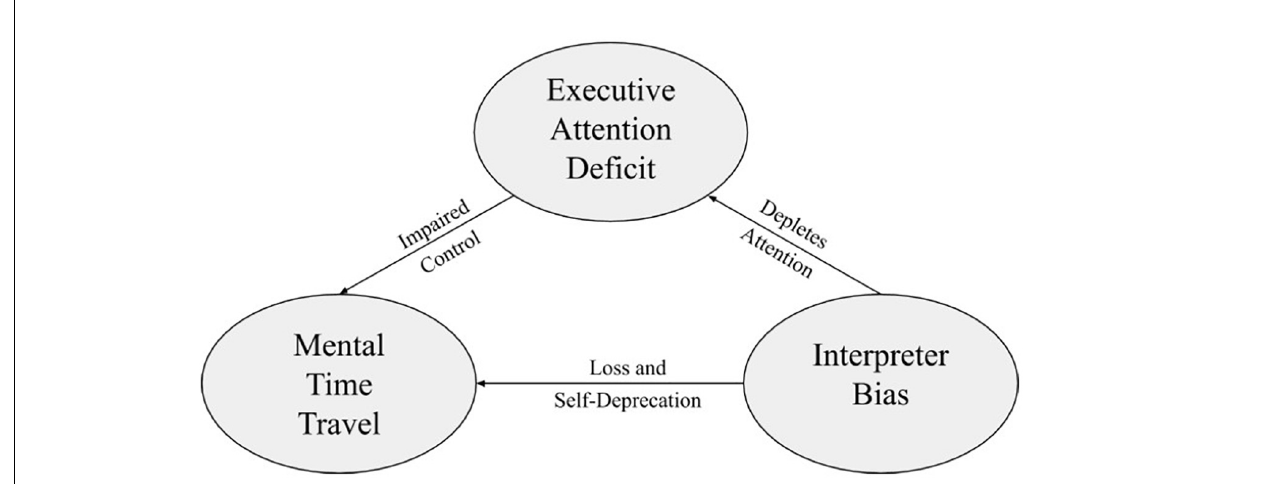
FIGURE 1 | Model of major depressive